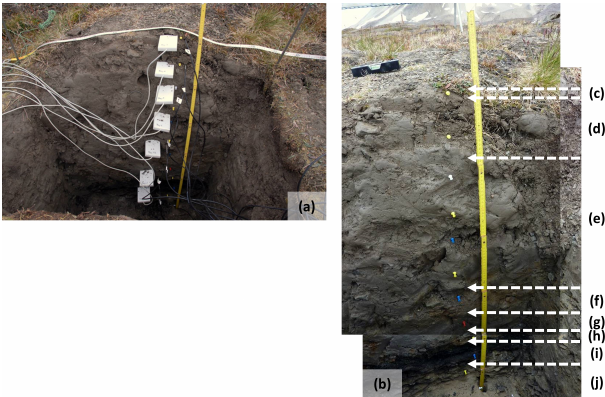
Figure C5. (a) Vertically installed time-domain reflectometry (TDR) air–snow TDR probe (50cm length) above the ground sur- face during summer at the Bayelva climate station (1999). Dur- ing winter (fully snow covered), the dielectric number of snow is recorded. (b) PT100 temperature sensors in air (summer) at 4 and 20cm above ground surface. (c) PT100 temperature sensors in snow (winter) with air gaps around cables and sticks; the TDR probe is completely covered with snow and not visible from the surface.